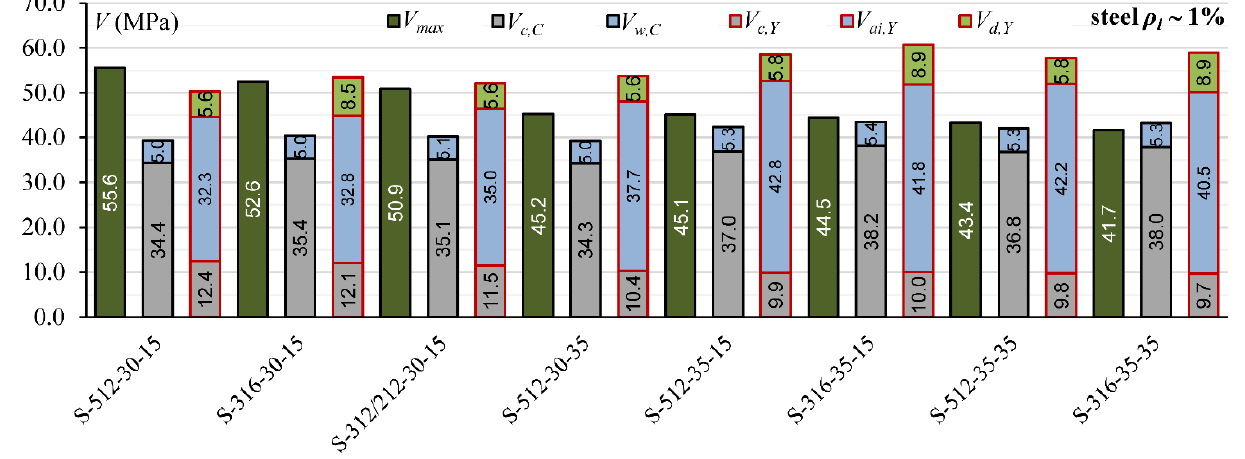
Figure 8. The comparison of shear mechanism contribution for GFRP-reinforced beams with rein- forcement ratio ρ l ~ 1% for Cladera et al.’s and Yang’s models.